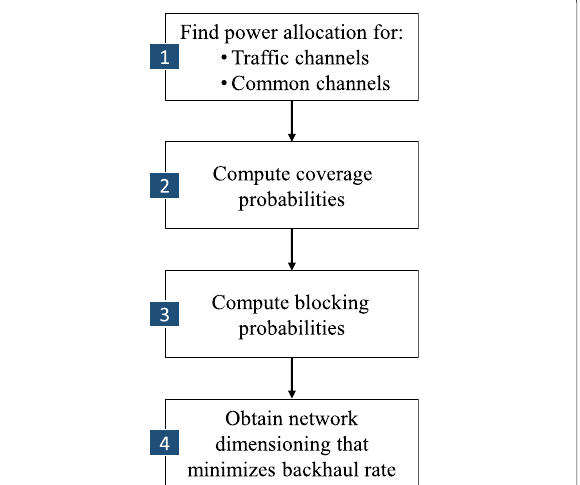
Fig. 5 Methodology presented in the paper to carry out the network